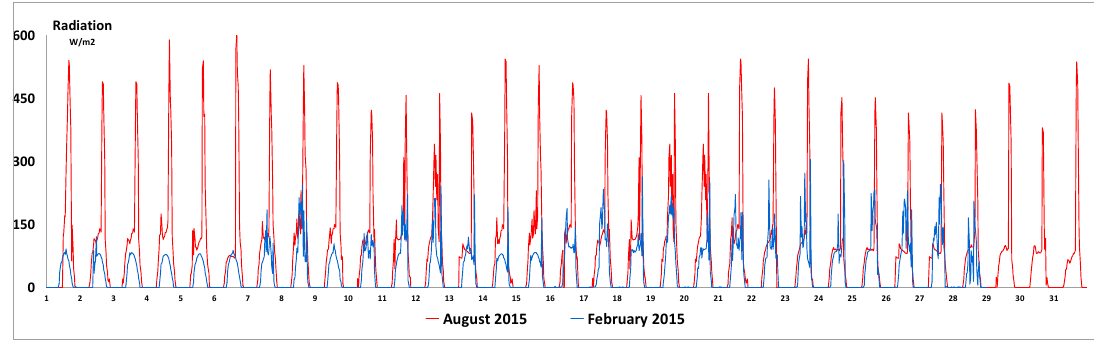
Figure 26. The solar radiation values collected in situ for the months of August and February 2015.